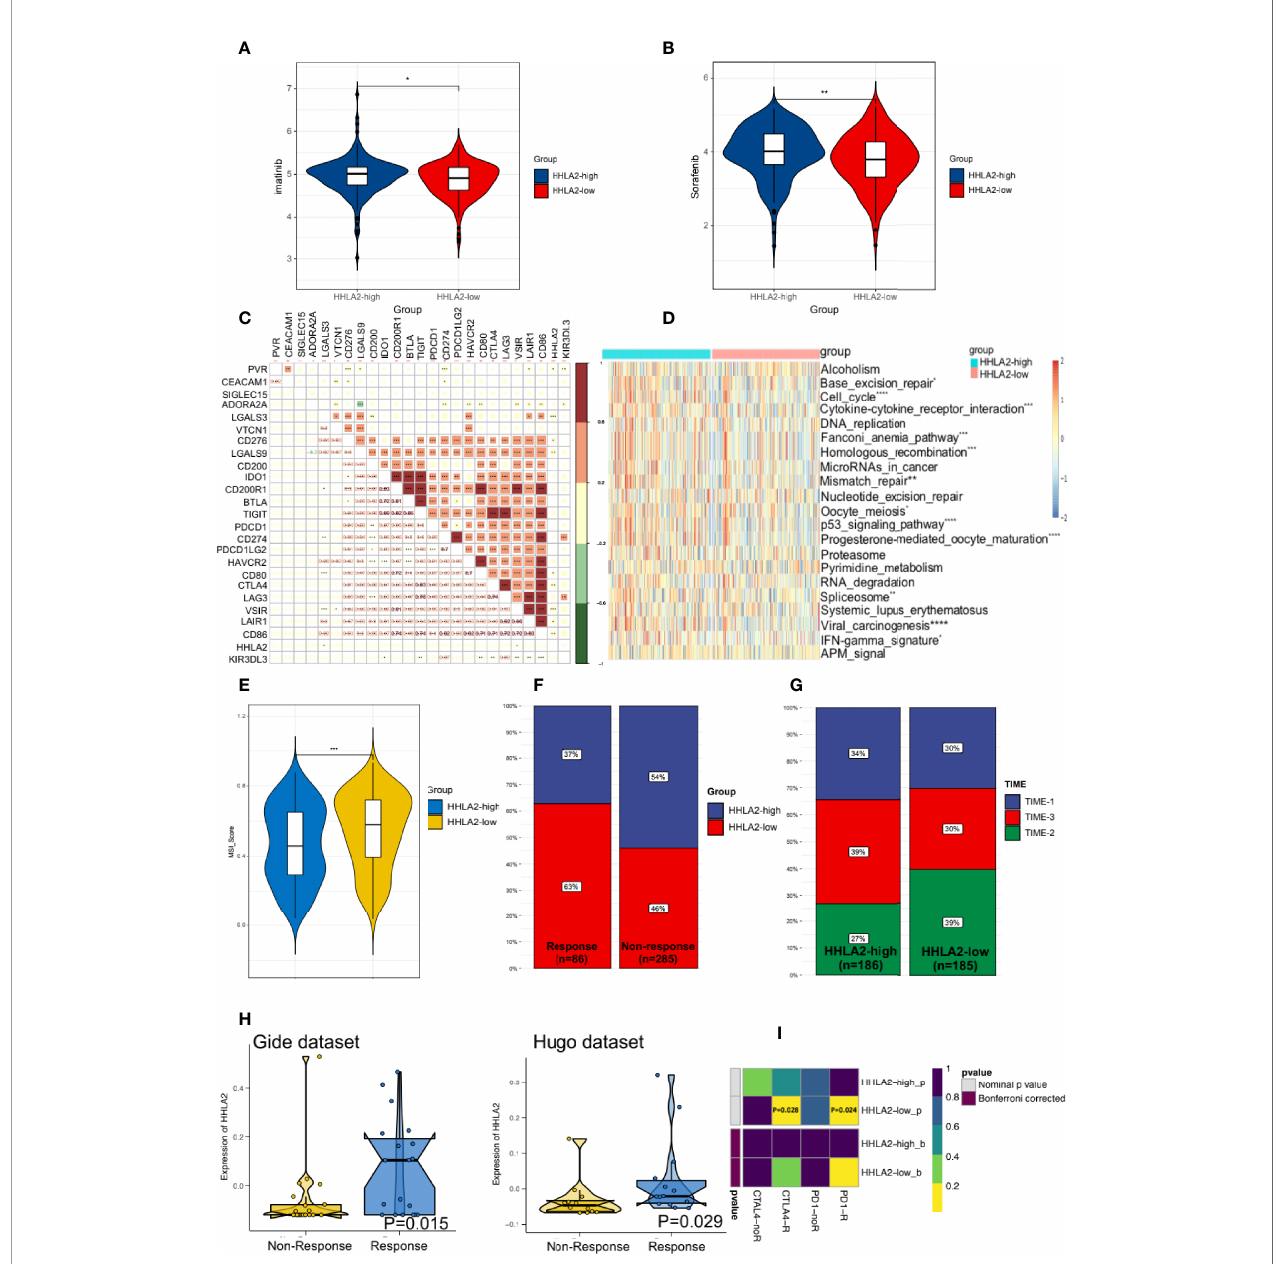
FIGURE 7 | HHLA2 expression could predict the clinical bene fi ts of immunotherapy and chemotherapy. (A) Differences of the estimated IC50 of imatinib between two subgroups. (B) Differences of the estimated IC50 of sorafenib between two subgroups in the database. (C) Correlation between HHLA2 and other inhibitory checkpoints. (D) Comparison of ICB-related response scores between subgroups. (E) TIDE predicted higher MSI score in HHLA2-low subgroup. (F) Comparison of HHLA2 expression between the responders and non-responders. (G) Distribution of TIME types in different groups. (H) Expression of HHLA2 between responder and non-responders in two immunotherapy cohorts. (I) Prediction of response to ICBs (anti-PD1 and anti-CTLA4) therapy in HHLA2-high and HHLA2-low subgroups. *p < 0.05, **p < 0.01, ***p < 0.001, ****p <